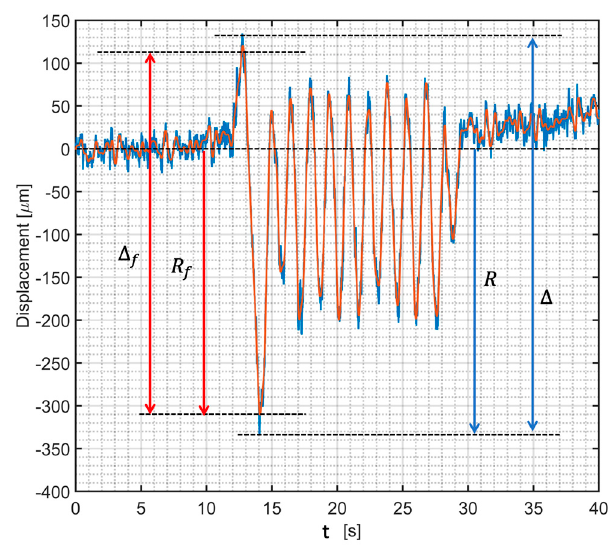
Figure 11. Detected range displacement of the B-point during the passage of a passenger train at 60 km/h (nominal speed) forward East.